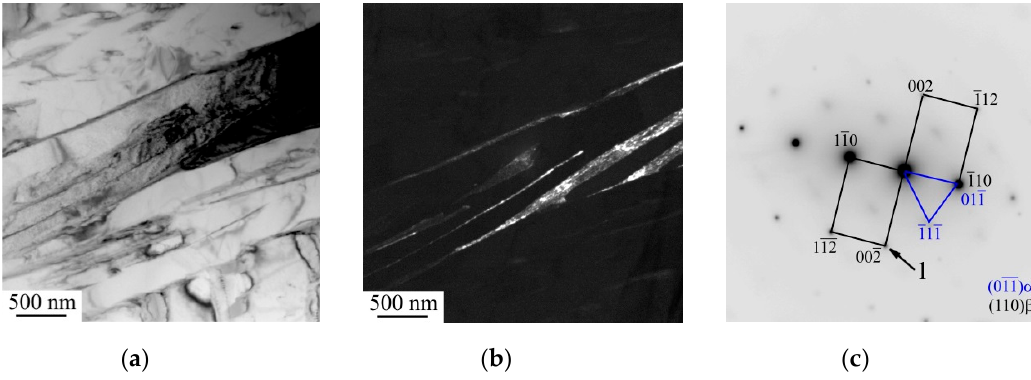
Figure 9. TEM bright- ( a ) and dark-field images ( b ) and associated SAED pattern ( c ) of the microstructures of the core of the EBF 3 -fabricated Ti–6Al–4V sample. The dark-field TEM image obtained with the 002 β -Ti reflection (marked by an arrow 1 in ( c )).